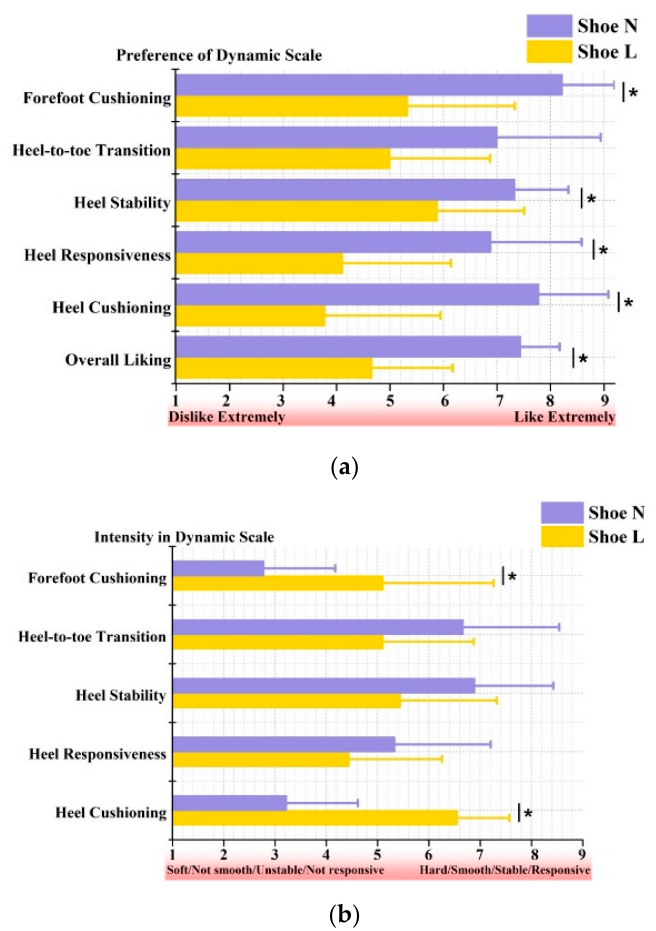
Figure 7 . (a) Effect of different basketball shoes (N vs. L) on preference of dynamic scale; (b) effect of Figure 7. ( a ) E ff ect of di ff erent basketball shoes (N vs. L) on preference of dynamic scale; ( b ) e ff ect of different basketball shoes (N vs. L) on intensity in dynamic scale. di ff erent basketball shoes (N vs. L) on intensity in dynamic